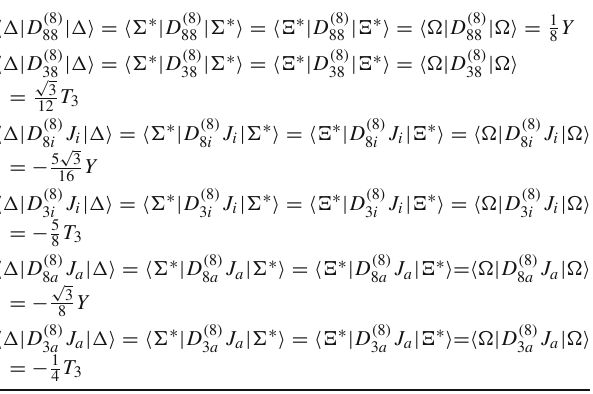
Table 8 The relevant transition matrix elements of the collective oper- ators coming from the 35plet component of the baryon wave functions for the electric monopole form factors